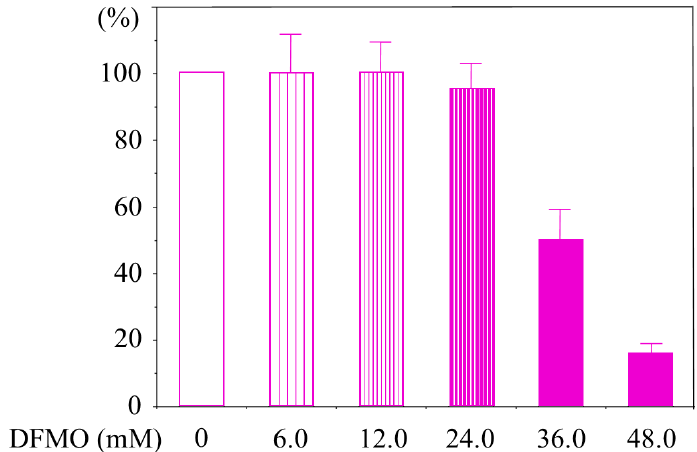
Figure A2. Cell viability and activity analyses (HMEpCs). Viability of HMEpCs cultured in 96-well with various concentrations of DFMO was analyzed by MTT assay. DFMO concentrations of up to 24 mM were not toxic to HMEpCs. The values were relative to the control (cells cultured in unsupplemented culture medium). Data are shown as means and standard deviations of four experiments ( n =